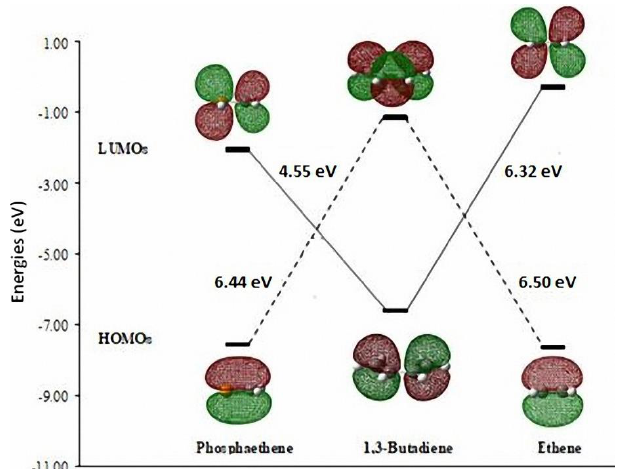
Figure 1. The HOMO-LUMO energy differences between FMOs of phosphaethene, 1,3-butadiene, and ethene calculated at the B3LYP/6-31+G** level.